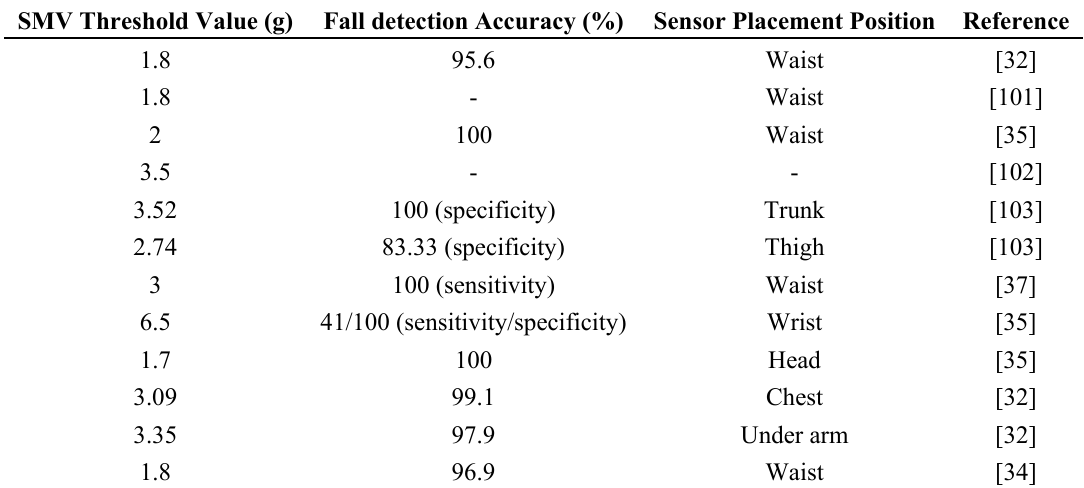
Table 9. Fall characteristic attributes and sensor data